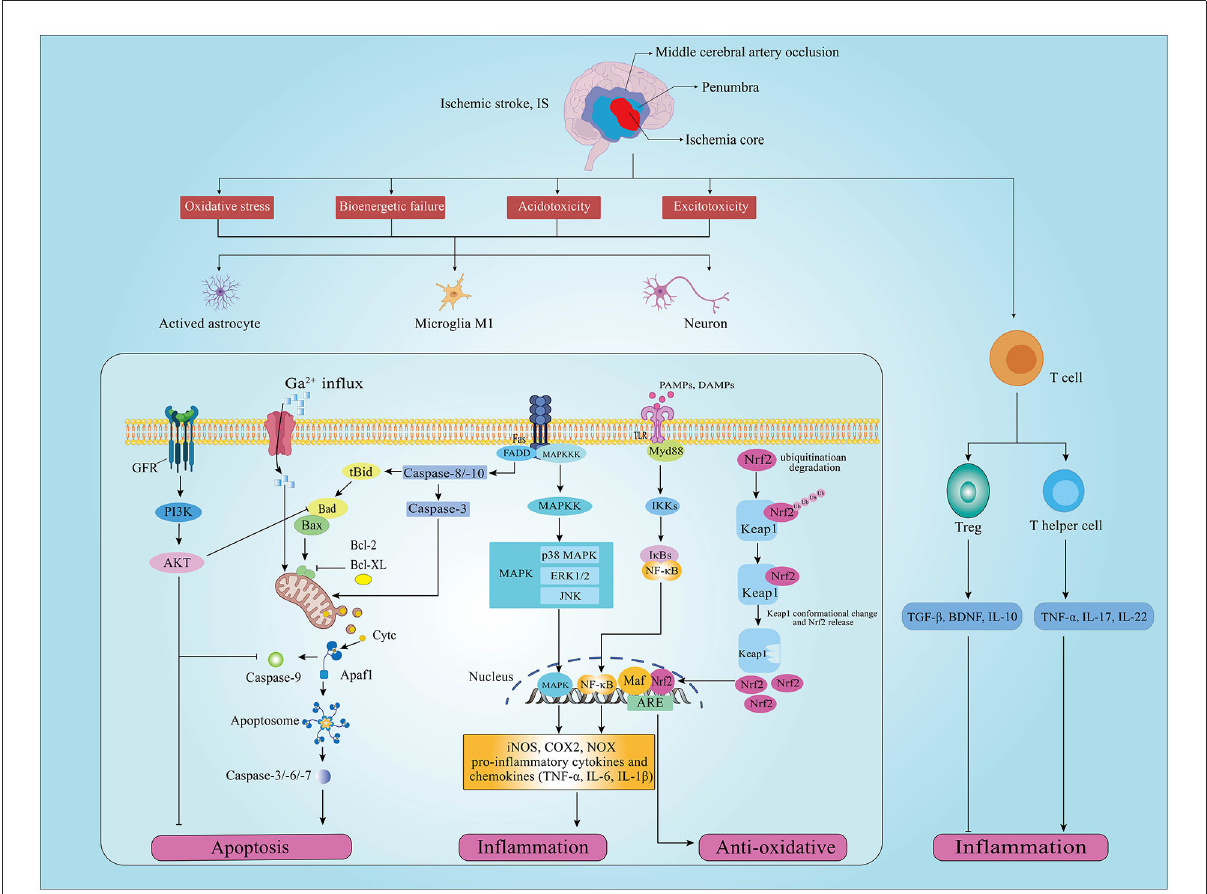
FIGURE1 Schematic diagram of oxidative stress, apoptosis, and inflammation signaling pathways involved in ischemic stroke (IS). Oxidative stress, inflammation and apoptosis occur in neurons of the penumbra after IS, which are regulated by different upstream pathways. (GFR, growth factor receptor; PI3K, phosphatidylinositol 3-kinase; AKT, protein kinase B; Bad, Bcl2 associated agonist of cell death; Bcl-2, B-cell lymphoma-2; Bcl-XL, B-cell lymphoma-extra large; Bax, Bcl-2-associated X; Cytc, cytochrome c; Apafl, apoptotic protease activating factor-1; TGF- β , transforming growth factor beta; BDNF, brain-derived neurotrophic factor; Keapl, Kelch-like ECH-associated protein 1; Nrf2, nuclear factor E2 related factor 2; Ub, ubiquitination; ARE, adenylate Uridylate-rich element; Maf, macrophage activating factor; TLR4, toll-like receptor 4;